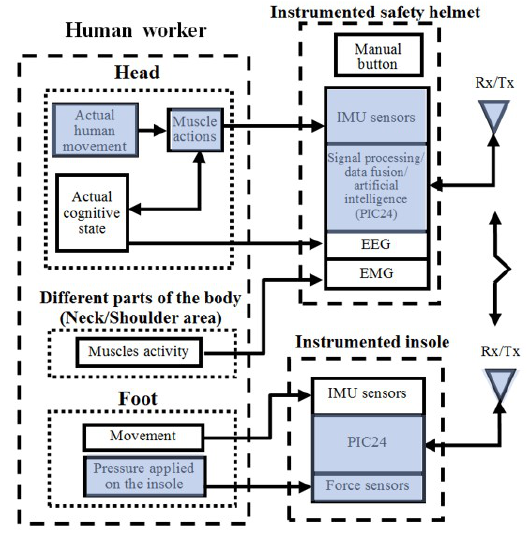
Figure 1. Block diagram of the overall interactive measurement tools (only the grey blocs are analyzed in this study).